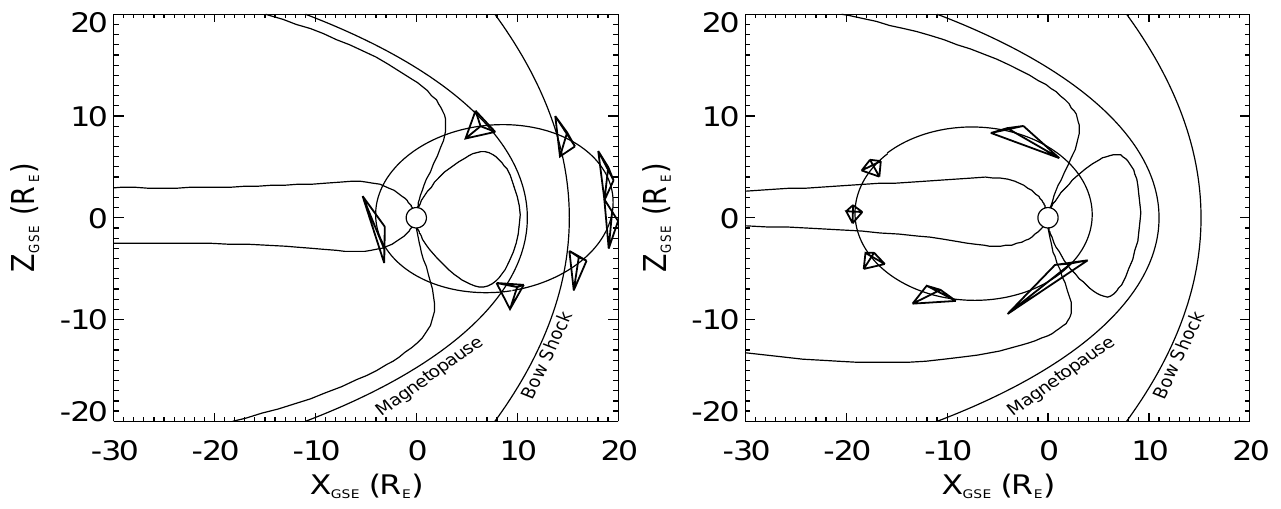
Fig. 2. Cluster orbits during polar cusp crossings (a) and tail crossings (b) . The orbit and spacecraft constellation are shown in red, the inter-spacecraft separation has been enlarged by a factor of 30 for the cusp and by a factor 5 for the tail. The size of the perfect tetrahedron in the cusp is 600km and in the tail,